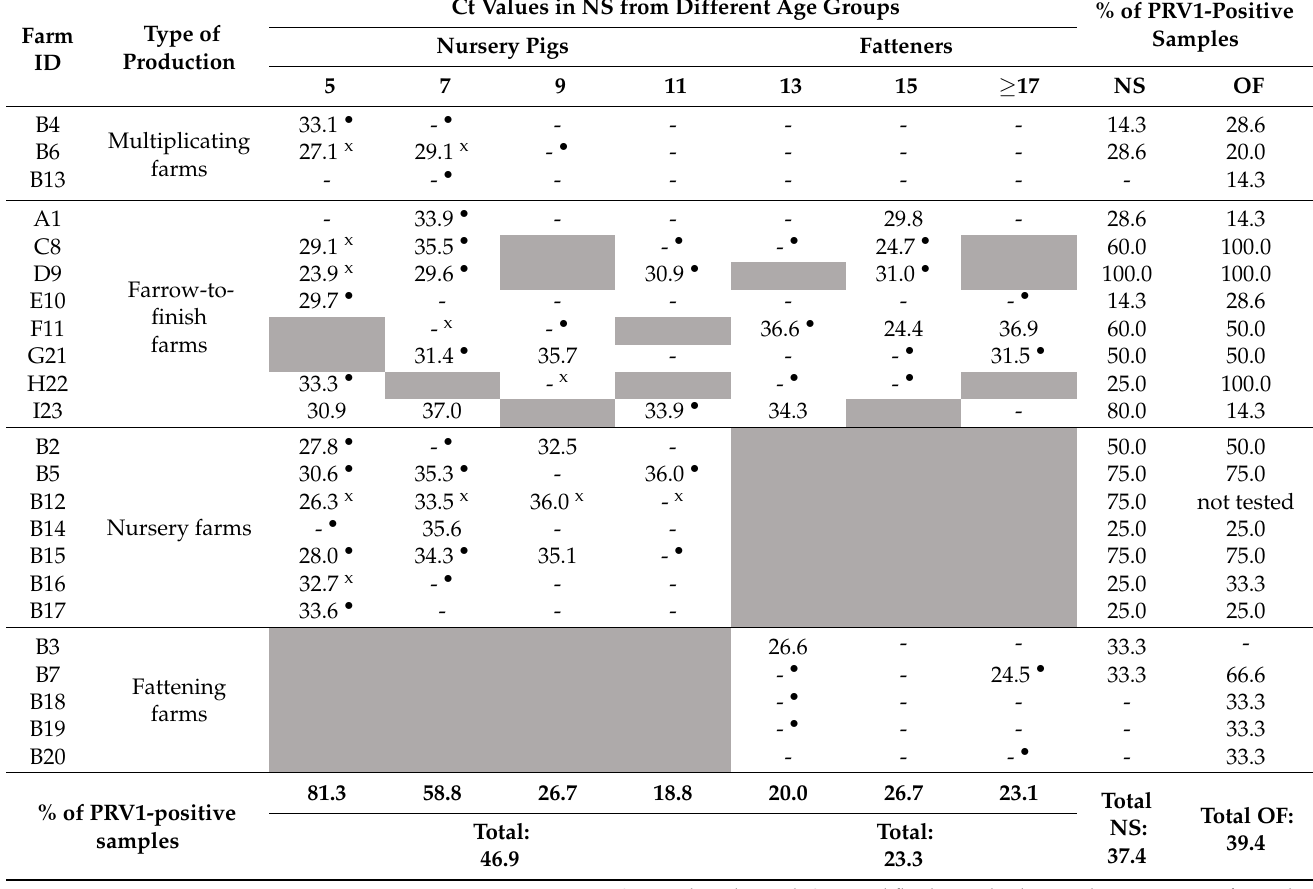
Table 1. The proportion of PRV1-positive NS and OF and summary of PRV1 real-time PCR results